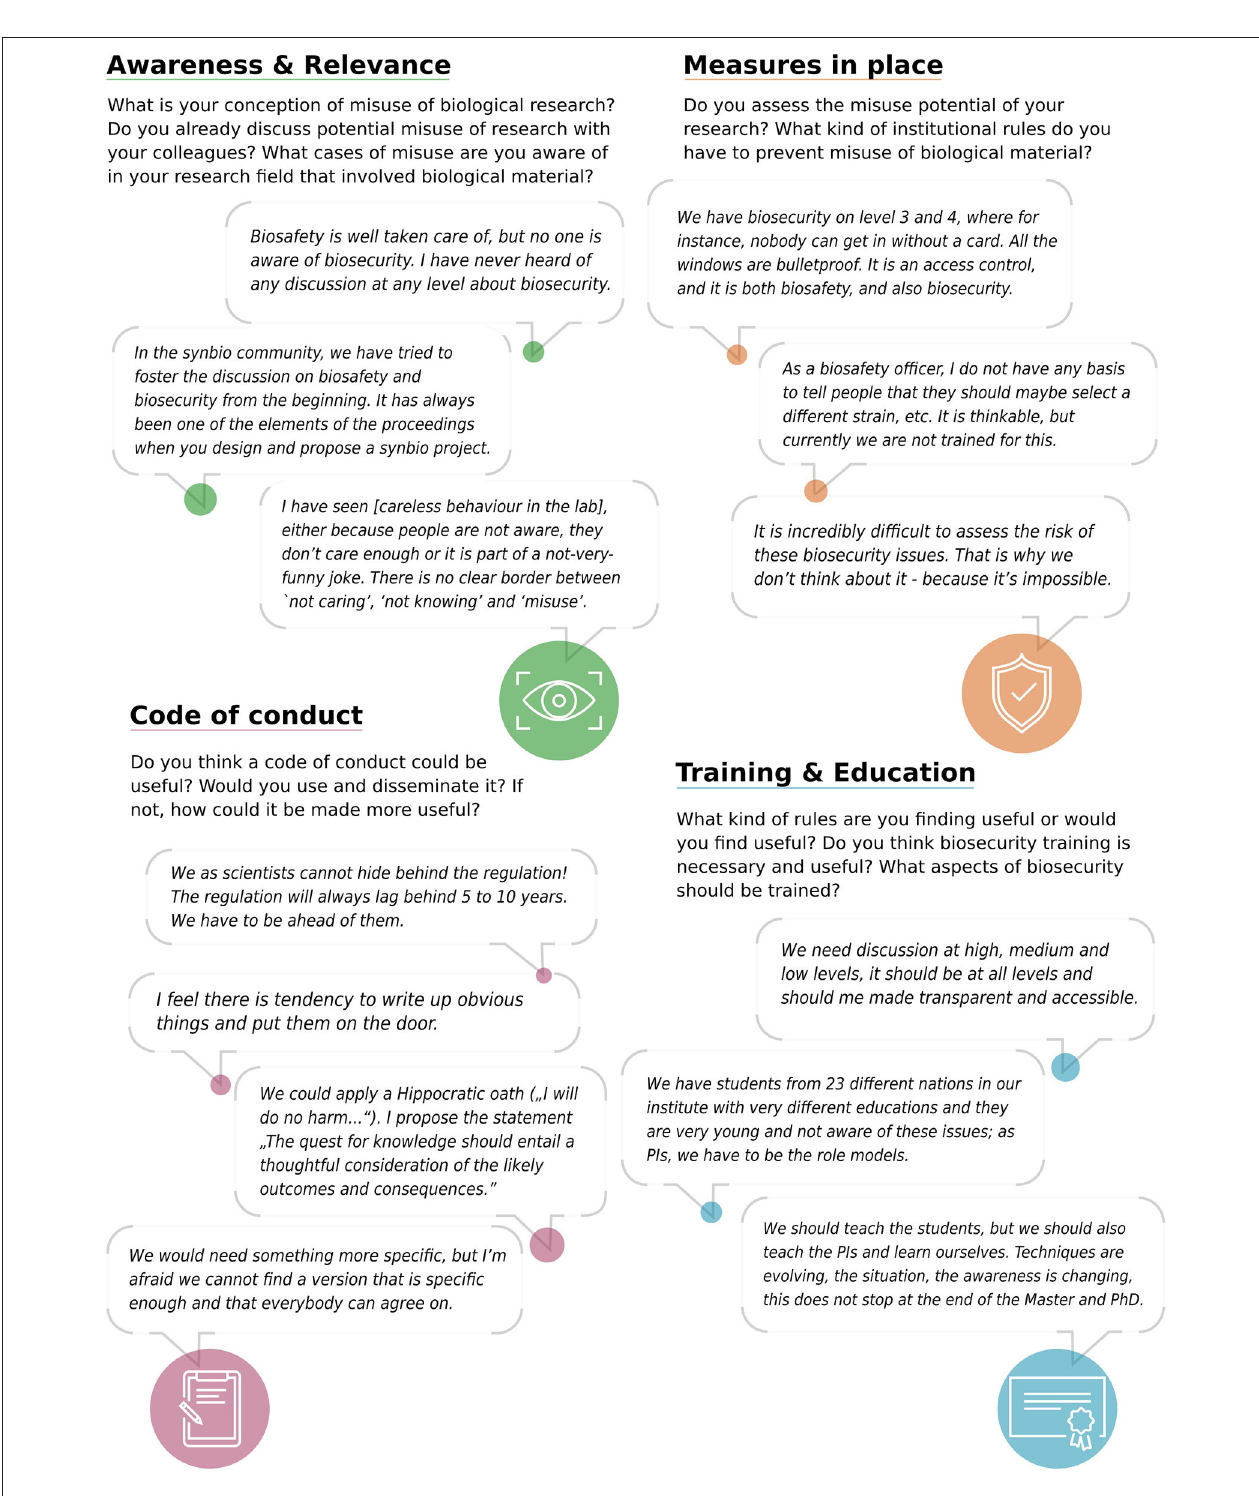
FIGURE 1 | Selection of questions asked during the discussion sessions and illustrative statements from participants in respect to the different topics addressed. and management as well as educational material. For a few participants, however, such measures wouldn’t go far